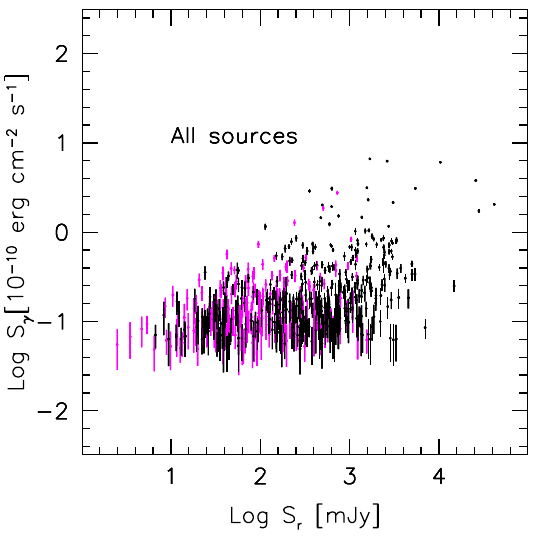
Figure 1. Gamma-ray energy flux at E > 100 MeV vs 8 GHz radio flux density for the 1LAC sample. Adapted from [5]. Magenta symbols indicate sources without a measured redshift.